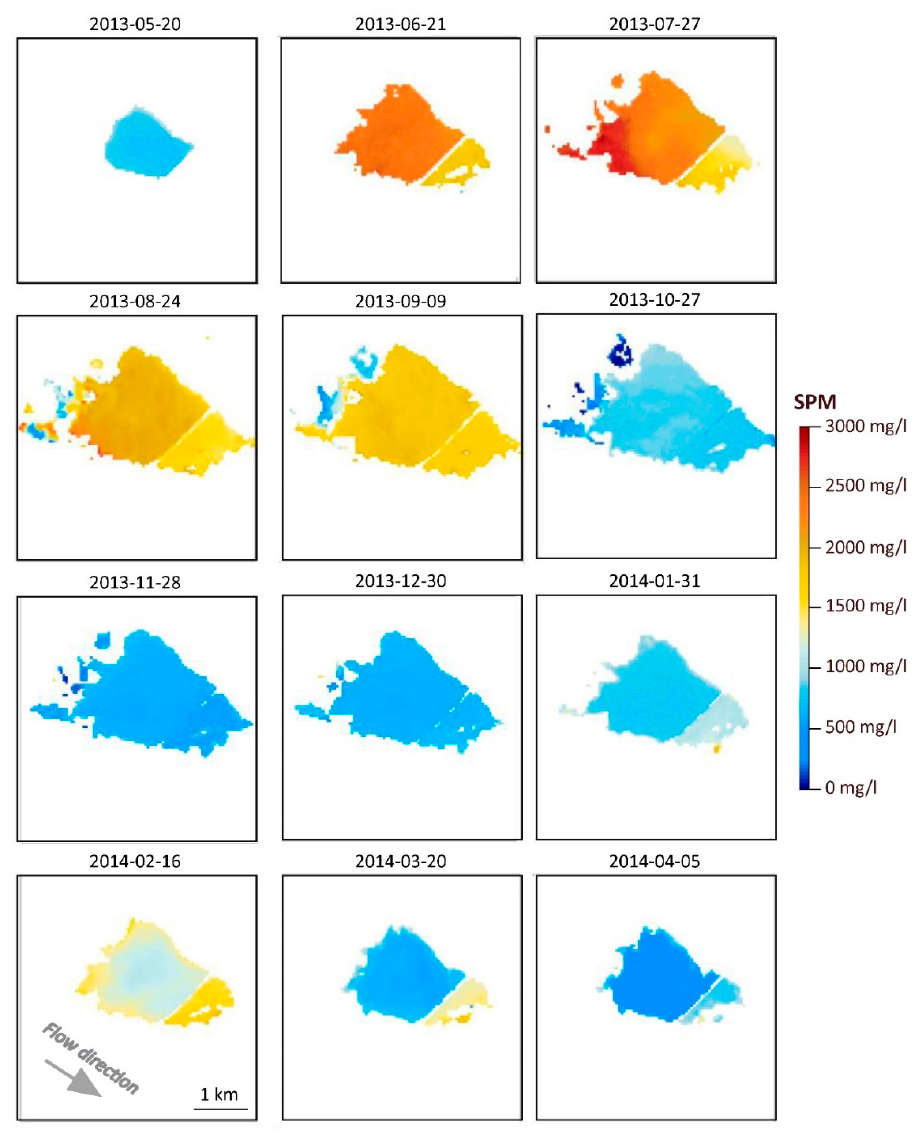
Figure 12. Spatial variability within the Agoufou Lake during 2013–2014.